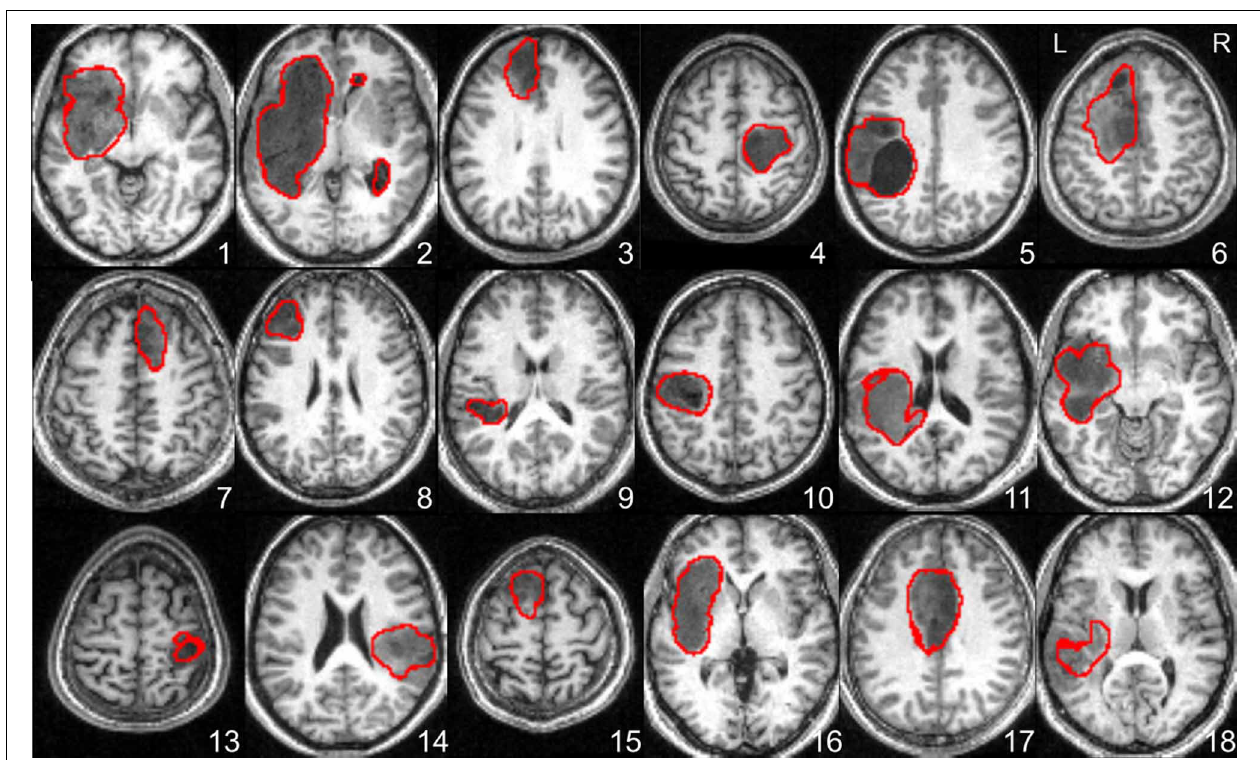
FIGURE 3 | Axial slices illustrating the lesion boundaries in each of the 18 patients as defined by the recursive ALI procedure detailed in Figures 1, 2. The tumor contour was obtained with a threshold of U > 0 . 3. L, Left; R,